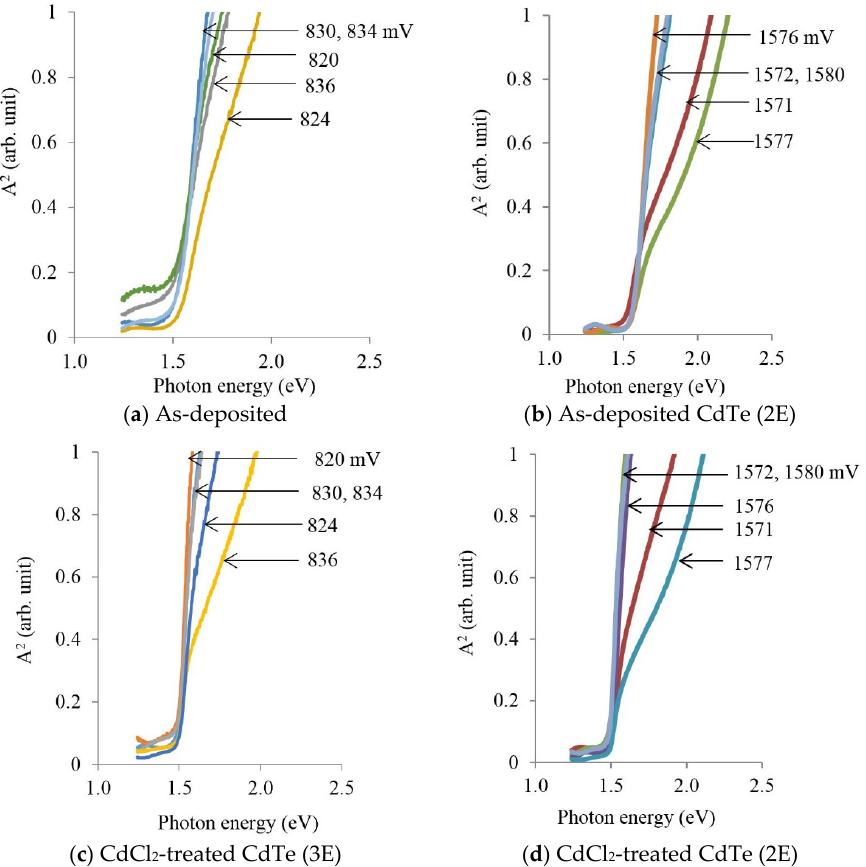
Figure 7. Optical absorption edges for as-deposited and CdCl 2 -treated CdTe layers grown using the 3E ( a , c ) and 2E ( b , d ) systems at different growth potentials. The films were heat-treated at 400 ◦ C for 15 minutes in air.